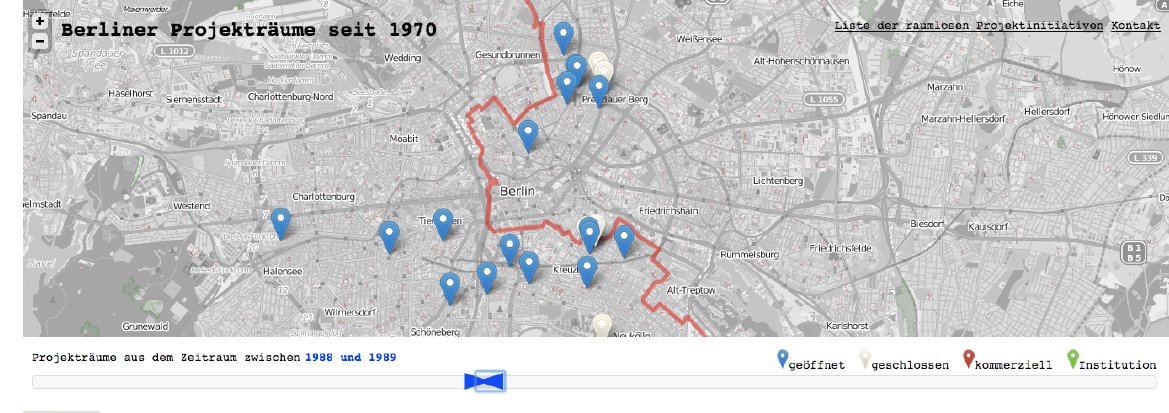
Interaktive Projekträumekarte, 1988-1988. Powered by Leaflet—Projektraum- daten und Webseite/Data and Webside: Séverine Marguin und Erik Streb del Toro. Data https://openstreetmap.org. Titles: http://wikimedia.org/ and http://